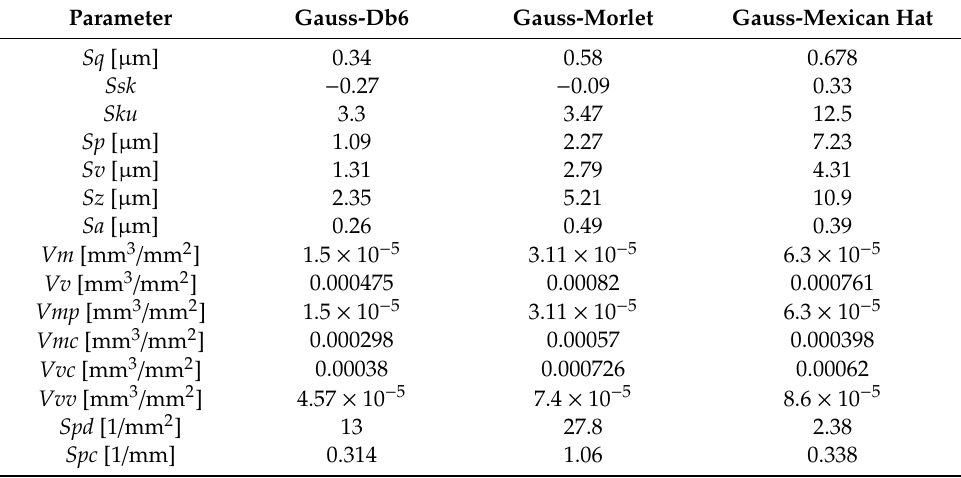
Figure 16. The surface of sample 1 with a flat-top structure after leveling and shape removal and application of ( a ) Gaussian filtration, ( b ) Daubechies wavelet, ( c ) Morlet wavelet, ( d ) Mexican hat wavelet. Table 2. Selected special parameters calculated for surfaces shown in Figure 17.